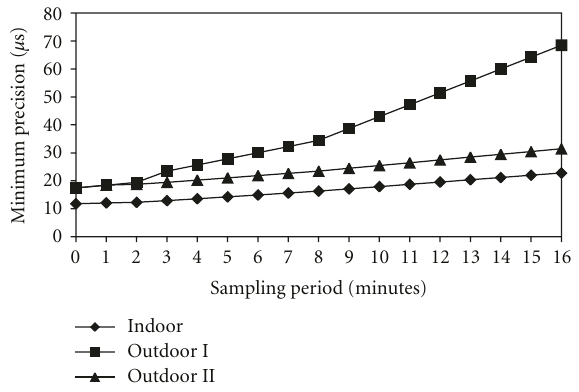
Figure 4: Minimum precision of WSN time versus sampling period, N CN = 10.